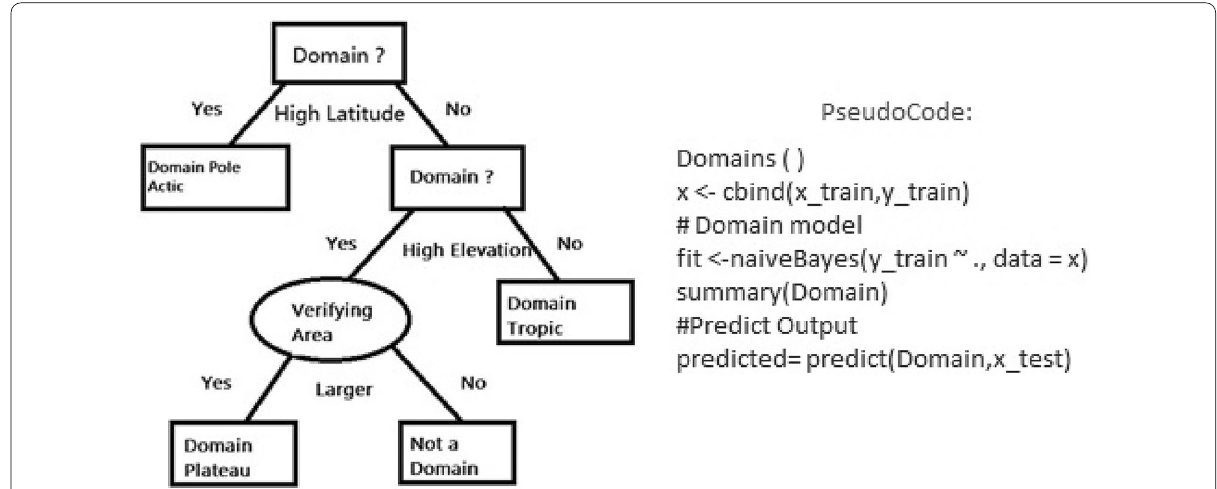
Fig. 1 Binary domain decision tree and